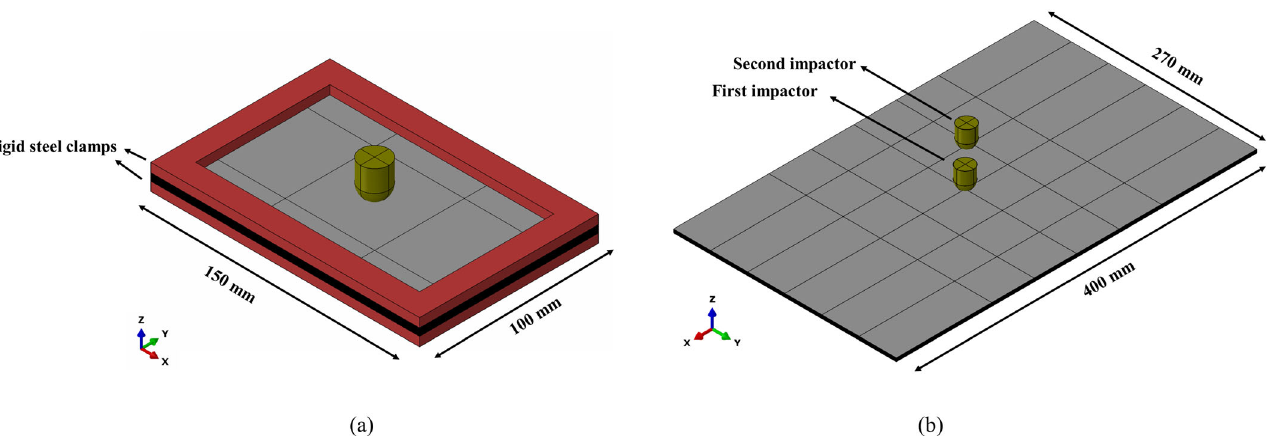
Table 1. Mechanical properties of CFRP composite.